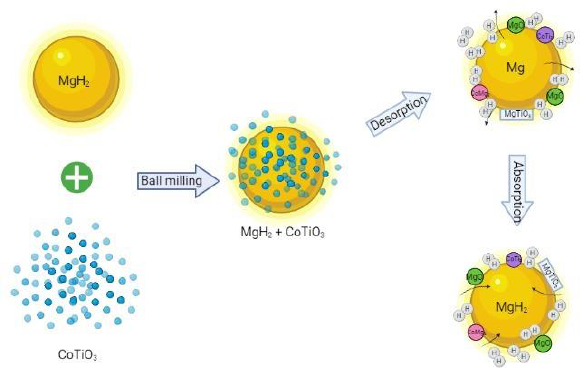
Figure 11. Schematic diagram of the catalytic mechanism of CoTiO 3 during the absorption/desorption process of the MgH 2 –CoTiO 3 system. During the milling process, the MgH 2 matrix reacts with CoTiO 3 . After undergoing the absorption and desorption process, MgTiO 3 , MgO and CoTi 2 , and CoMg 2 are formed in situ. These in situ active species may serve as an intermediate transfer getaway that accelerates the hydrogen absorption and desorption of MgH 2 . With the assistance of in situ formed MgTiO 3 , MgO and CoTi 2 , and CoMg 2 , the hydrogen storage behavior of MgH 2 is significantly improved.